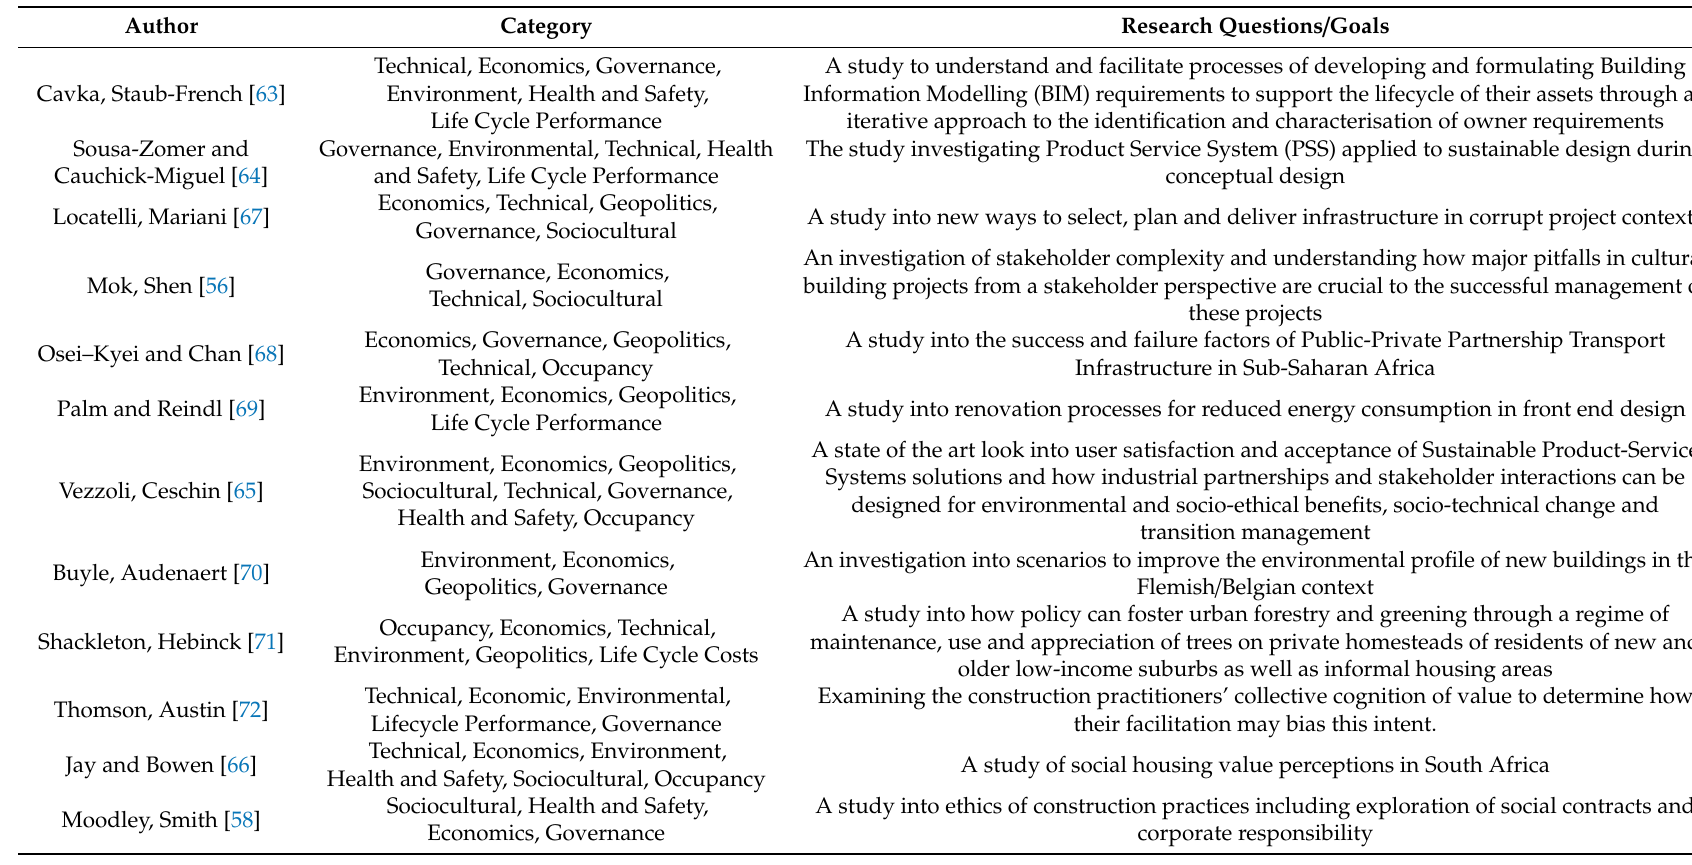
Table 3. Selected literature on the requirements